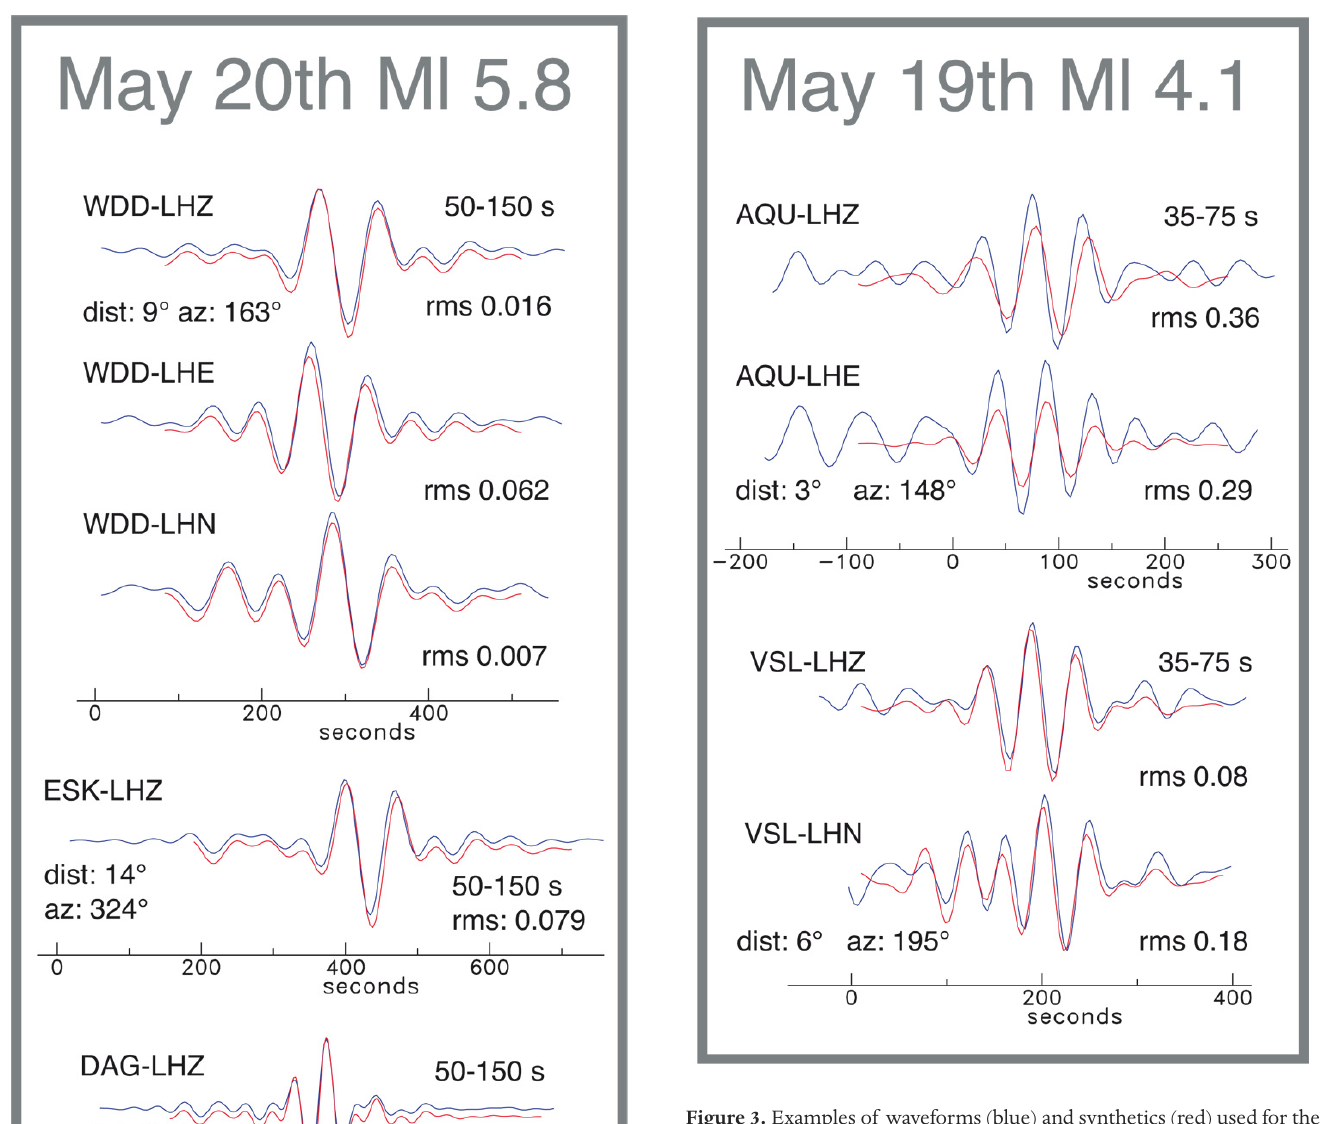
5.8 event. L 4.1 L